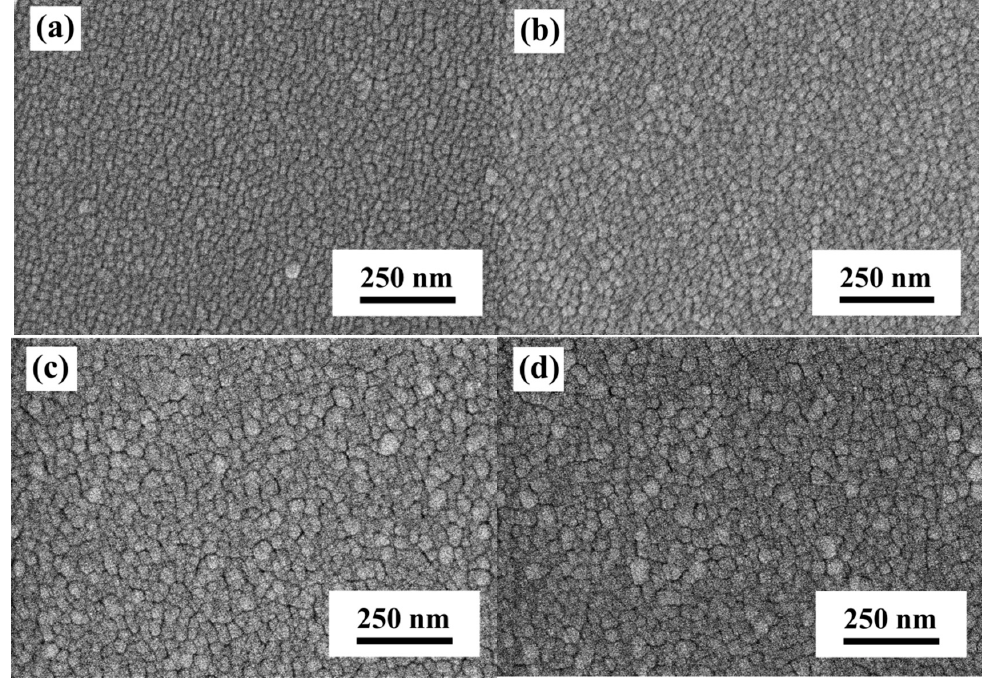
Figure 7. Surface SEM images of the α -IGZO/Ag/ α -IGZO triple-layer structure as a function of thickness of IGZO film, where thickness was ( a ) 27; ( b ) 41; ( c ) 55; and ( d ) 69 nm, respectively.